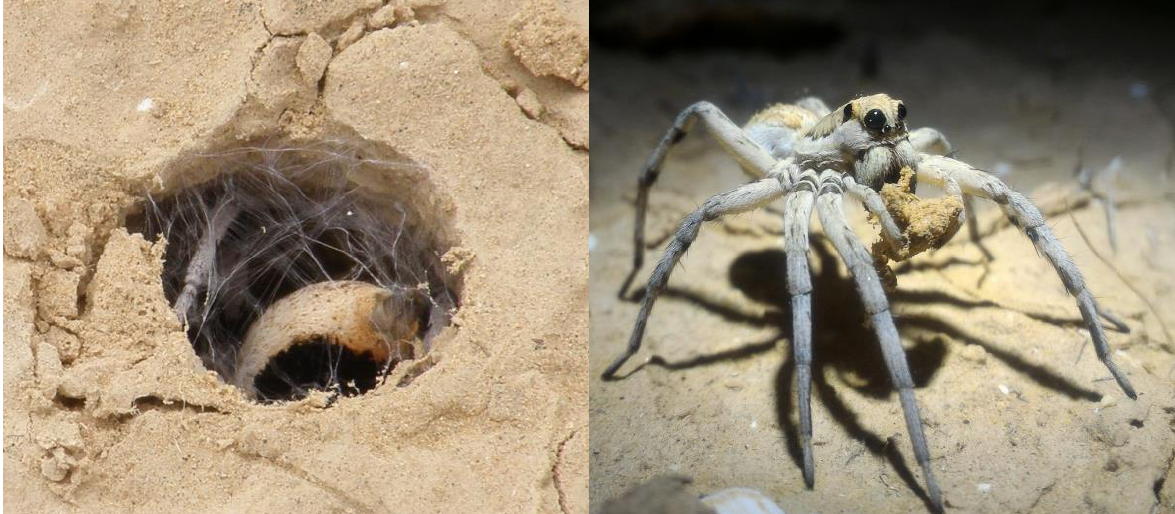
Figure 5. Typical responses of Lycosa hyraculus to trapdoor removal. A spider spins a mesh in its burrow entrance ( left ); a spider carries a piece of soil in its pedipalps and chelicerae, possibly to replace a trapdoor ( right ). Spiders may also carry soil during burrow maintenance when they remove accumulated soil by binding it into balls with silk.